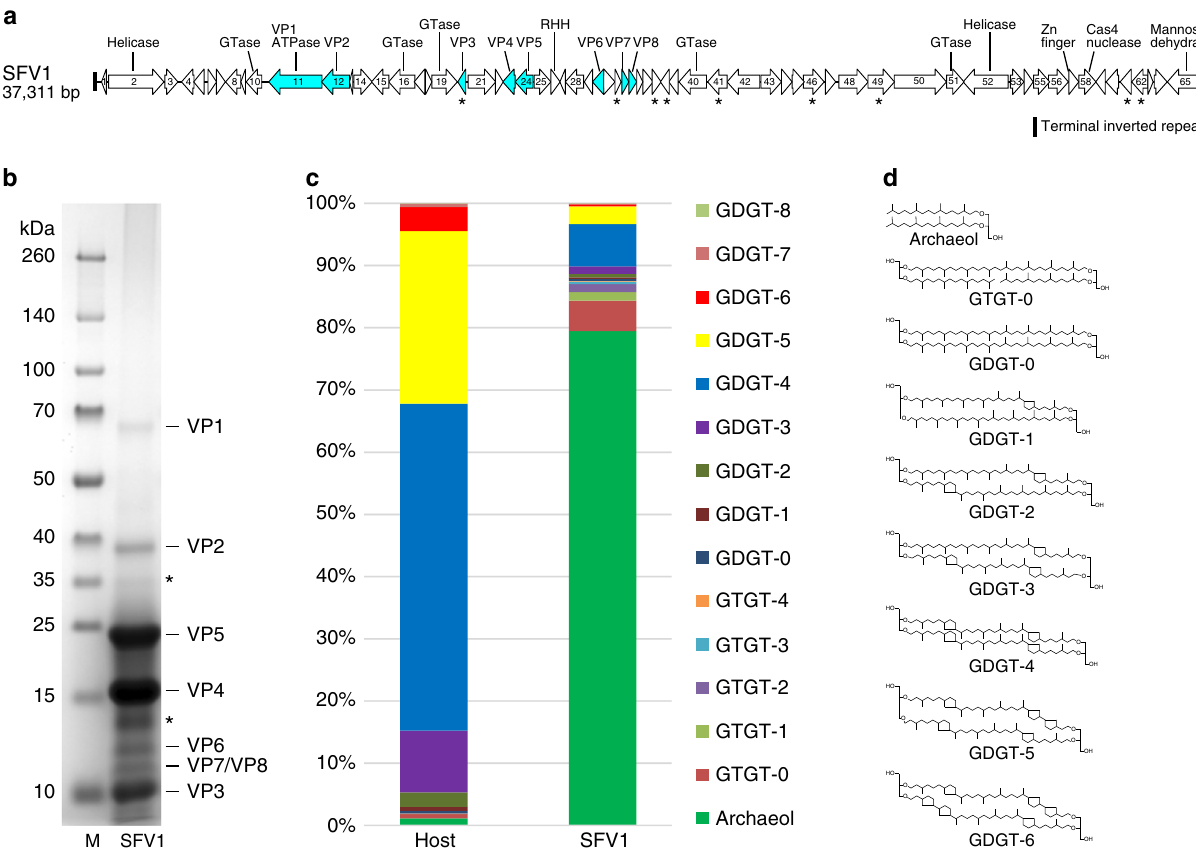
Fig. 2 Genes, proteins, and lipids of SFV1. a Genome map of SFV1. The ORFs are represented with arrows, indicating the direction of transcription. Genes encoding structural proteins are in blue, and ORFs containing predicted transmembrane domains are indicated by asterisks. b SDS-PAGE of SFV1 virion proteins stained with Coomassie brilliant blue. The VPs which were identi fi ed in proteins bands are indicated. The protein bands marked by asterisks contained a mixture of different VPs in comparable proportion. c Distribution of lipid species identi fi ed in S. shibatae BEU9 cells (Host) and SFV1 virions. d Chemical diagrams for the lipid species identi fi ed in SFV1 virions and S. shibatae BEU9 cells. M molecular mass